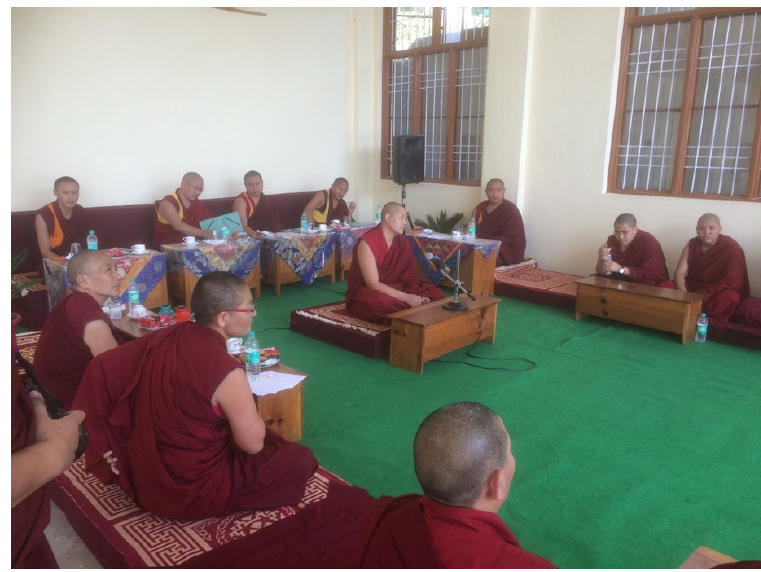
Figure 3. Debate test during the final exam for the geshema degree.